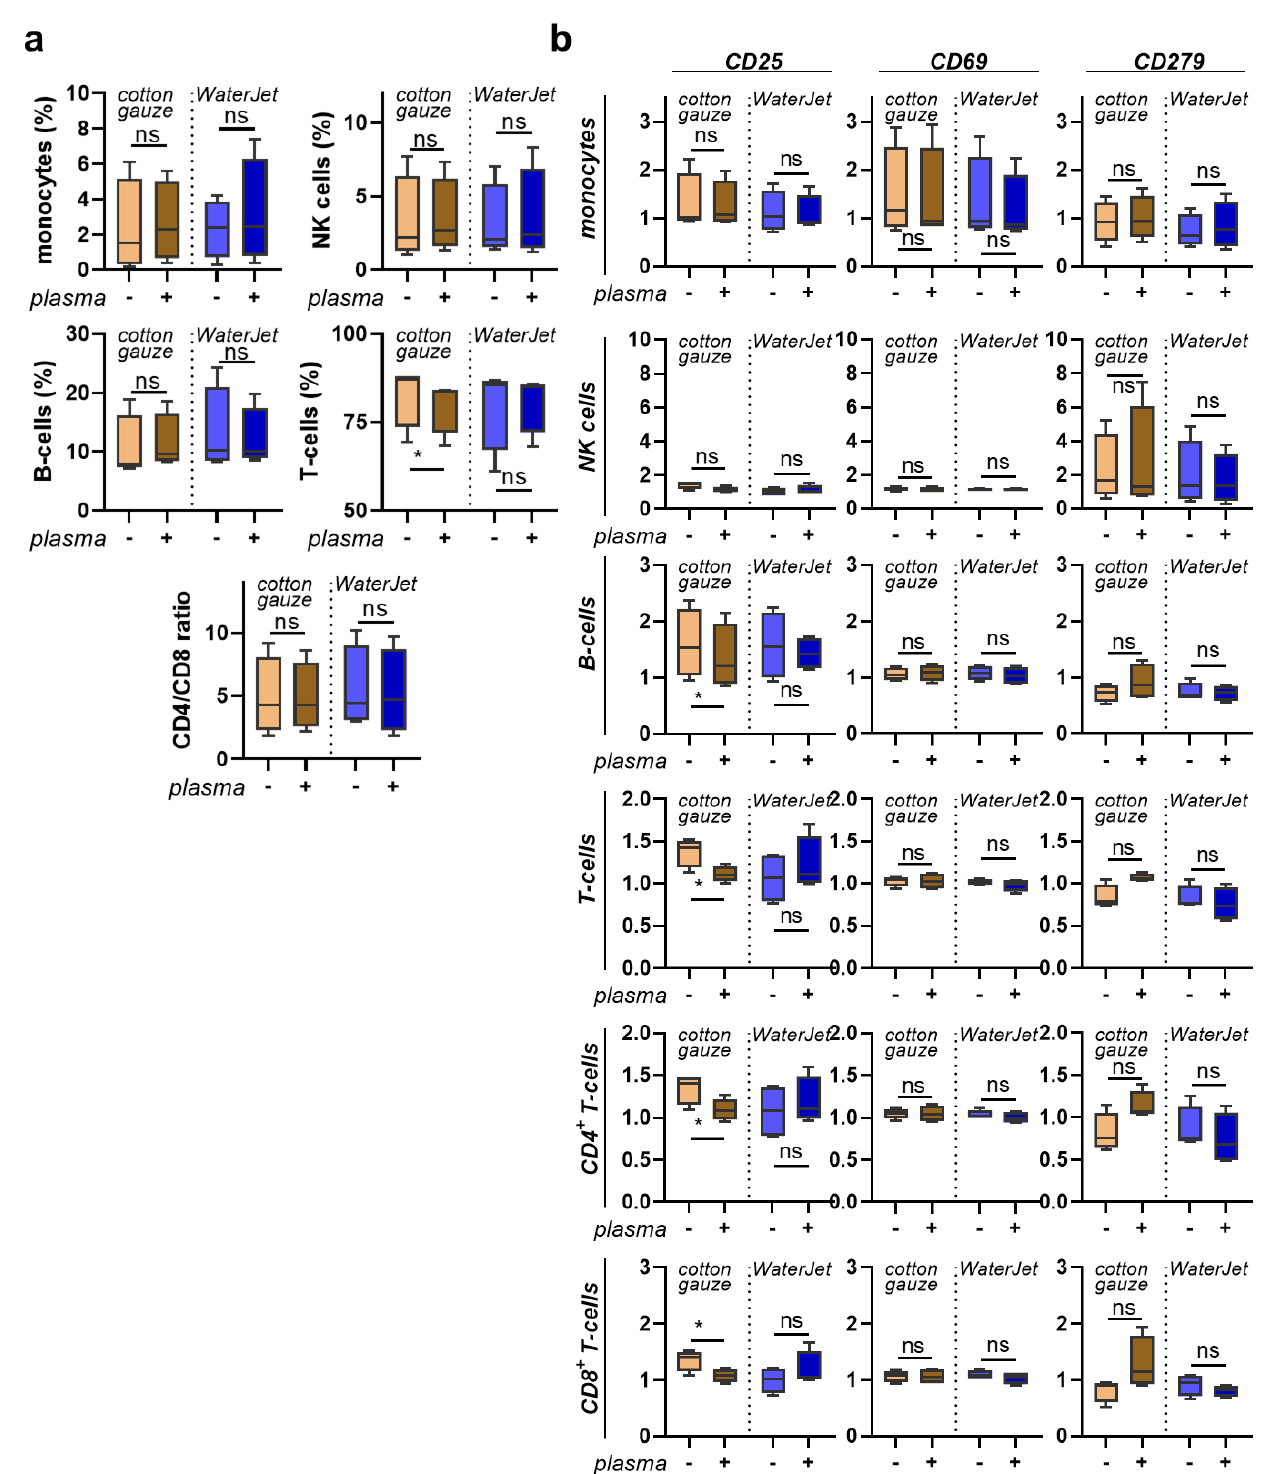
Figure A5. PBMC inflammation marker expression cultured on clean titanium discs. ( a ) percentages of leukocyte subpopulations across all leukocytes in cotton gauze and WaterJet ±CAP-treated titanium discs without subsequent addition of fixative; ( b ) surface marker expression of leukocyte subpopulations and data dependence on titanium disc pre-treatment. Data are from four donors and show boxplots and median of data normalised to untreated titanium discs. Statistical analysis was performed using paired t -test; * = p < 0.05, ns = not significant. PBMC from four different donors were tested. Biofilm was generated from subgingival plaque of a single periodontally diseased individual.